Question: Describe this figure in one sentence.
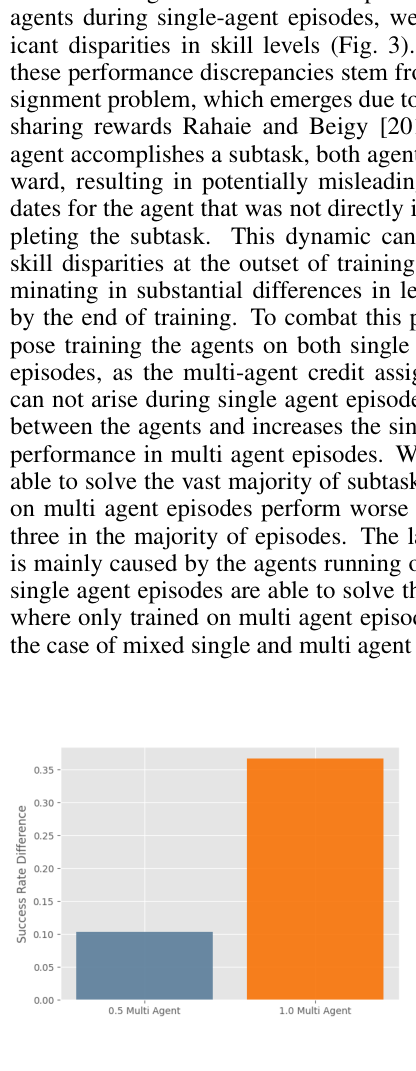
Answer: Mean stage 3 success rate dif- ference between two agents trained on 100% vs 50% multi agent episodes